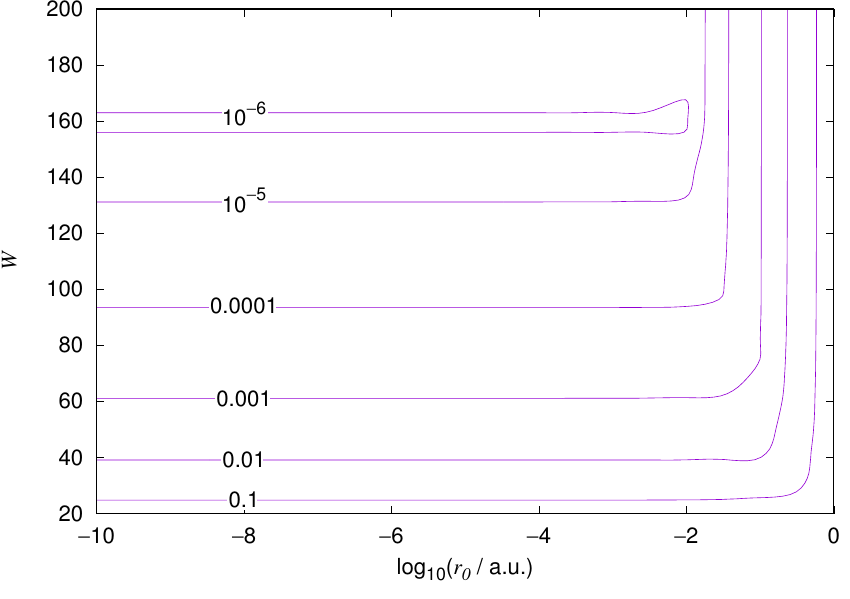
Figure 6. Relative error of the wavefunction value at the core radius for the hydrogen 2p orbital. Notations as in Figure